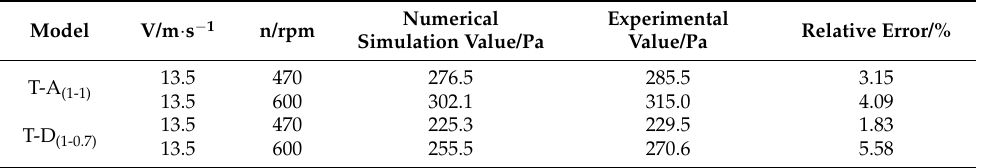
Table 3. Comparison of simulated and experimental pressure drop △ 𝑃 .